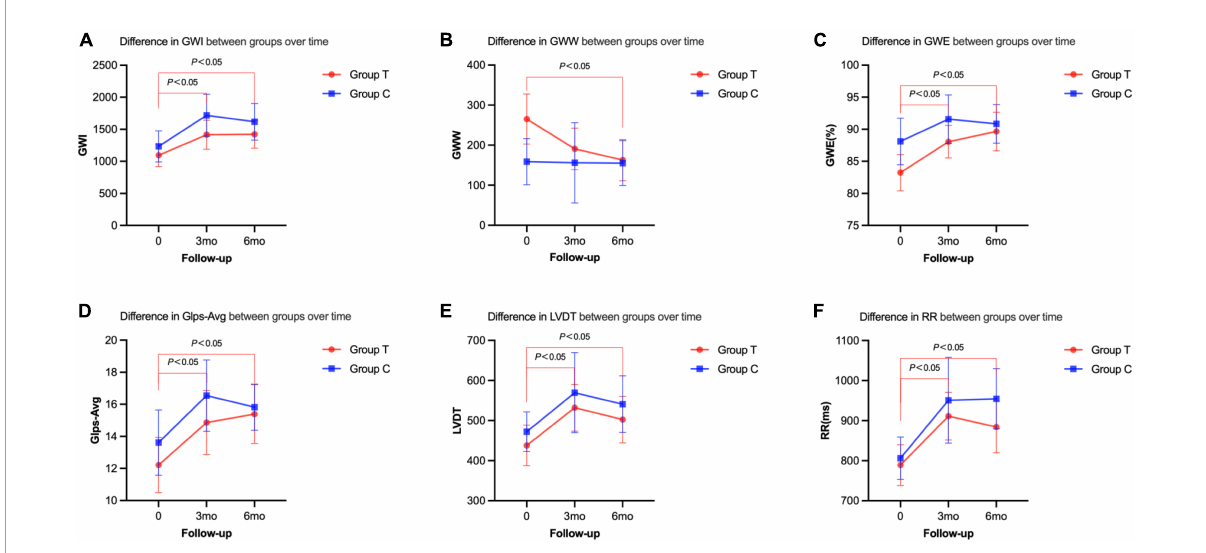
FIGURE3 Cardiac resynchronization parameters of the two groups before and after the treatment at 3 or 6 months follow-up. (A) Difference in GWI between groups over time. (B) Difference in GWW between groups over time. (C) Difference in GWE between groups over time. (D) Difference in Glps-Avg between groups over time. (E) Difference in LVDT between groups over time. (F) Difference in RR between groups over time.